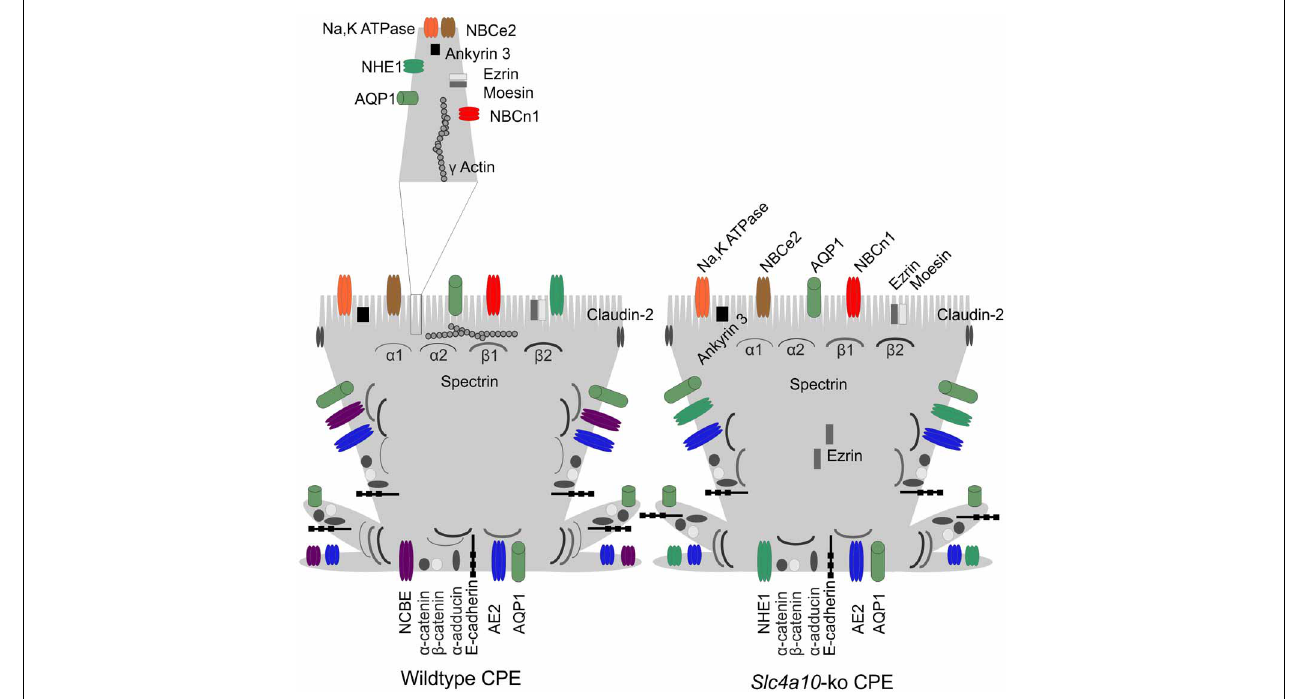
FIGURE 11 | Model of the subcellular position of membrane transporters, cytoskeletal components, and anchoring proteins in the CPE cell from normal and slc4a10 knockout mice, as indicated. The